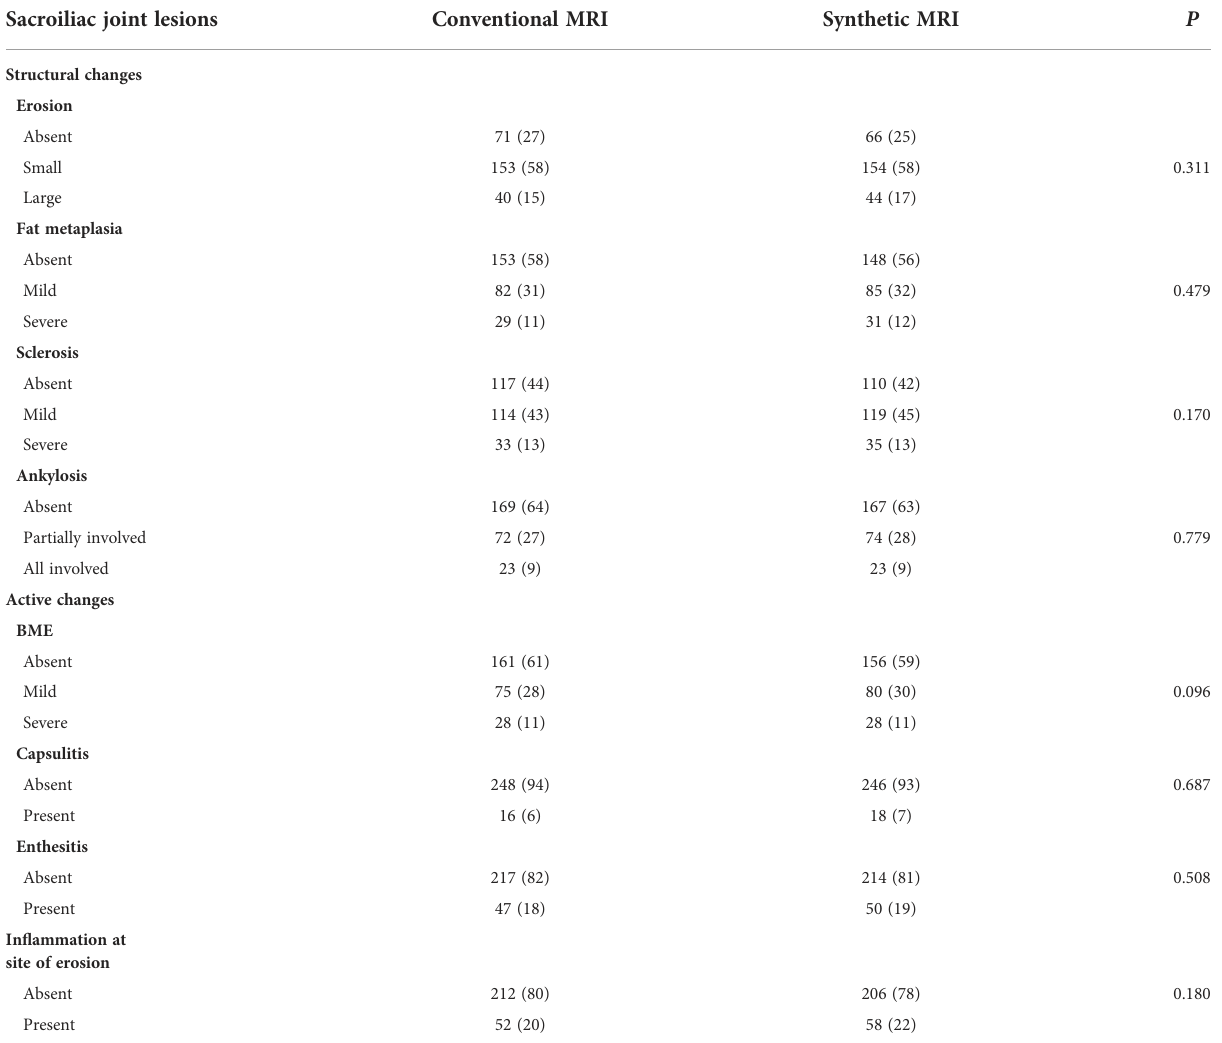
TABLE 2 Assessment of sacroiliac joint lesions with conventional and synthetic